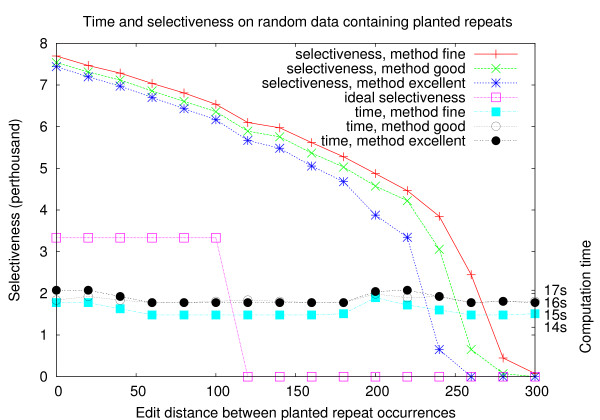
Tests on random generated sequences. Application of the three versions of TUIUIU with parameters (L, d, r) = (1000, 100, 5) on five random sequences of a total size of 1.5 Mb, each containing approximate occurrences of a planted repeat of length 1 kb. We planted repeats whose occurrences have a pairwise maximum distance that ranges from 0 to 300 (each test has the same value for all pairs). Each test was performed 20 times: the average result is reported.